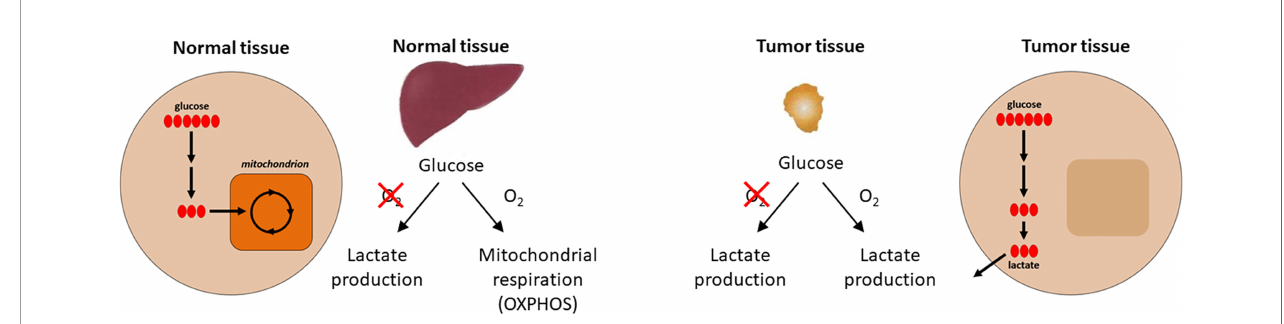
FIGURE 1 | Aerobic metabolic differences between normal and tumor tissues. Under aerobic conditions, normal tissues use OXPHOS for ATP production and cancer cells use glycolysis (the Warburg effect) for energy. Modi fi ed from an image created by the Patti Lab, Washington University, that appeared in the October 20, 2016, National Cancer Institute Cancer Currents Blog post, Metabolomics Study Reveals another Energy Source for Cancer Cells , with permission from Gary